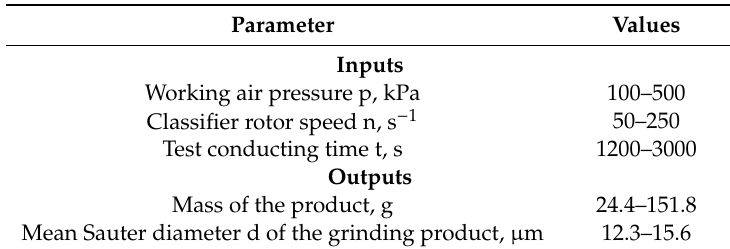
Table 2. Variables of the model.